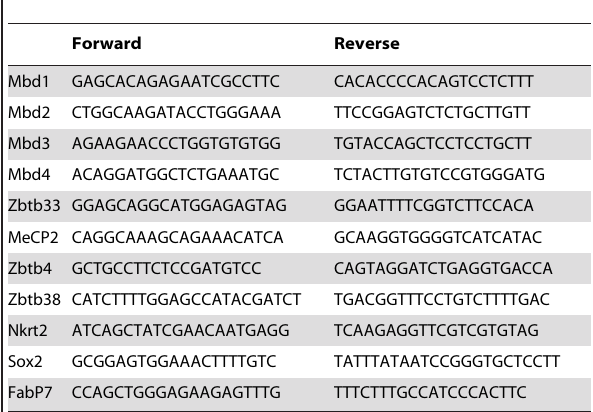
Table 2. RT-PCR Primers used in this study.